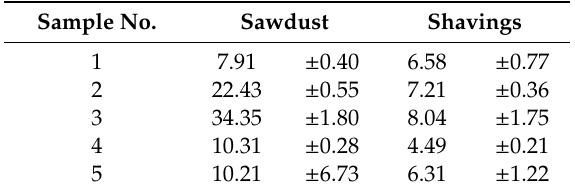
Table 2. Analysis of fixed carbon in the samples of Pinus spp. (%). Sample No. Sawdust Sample No.